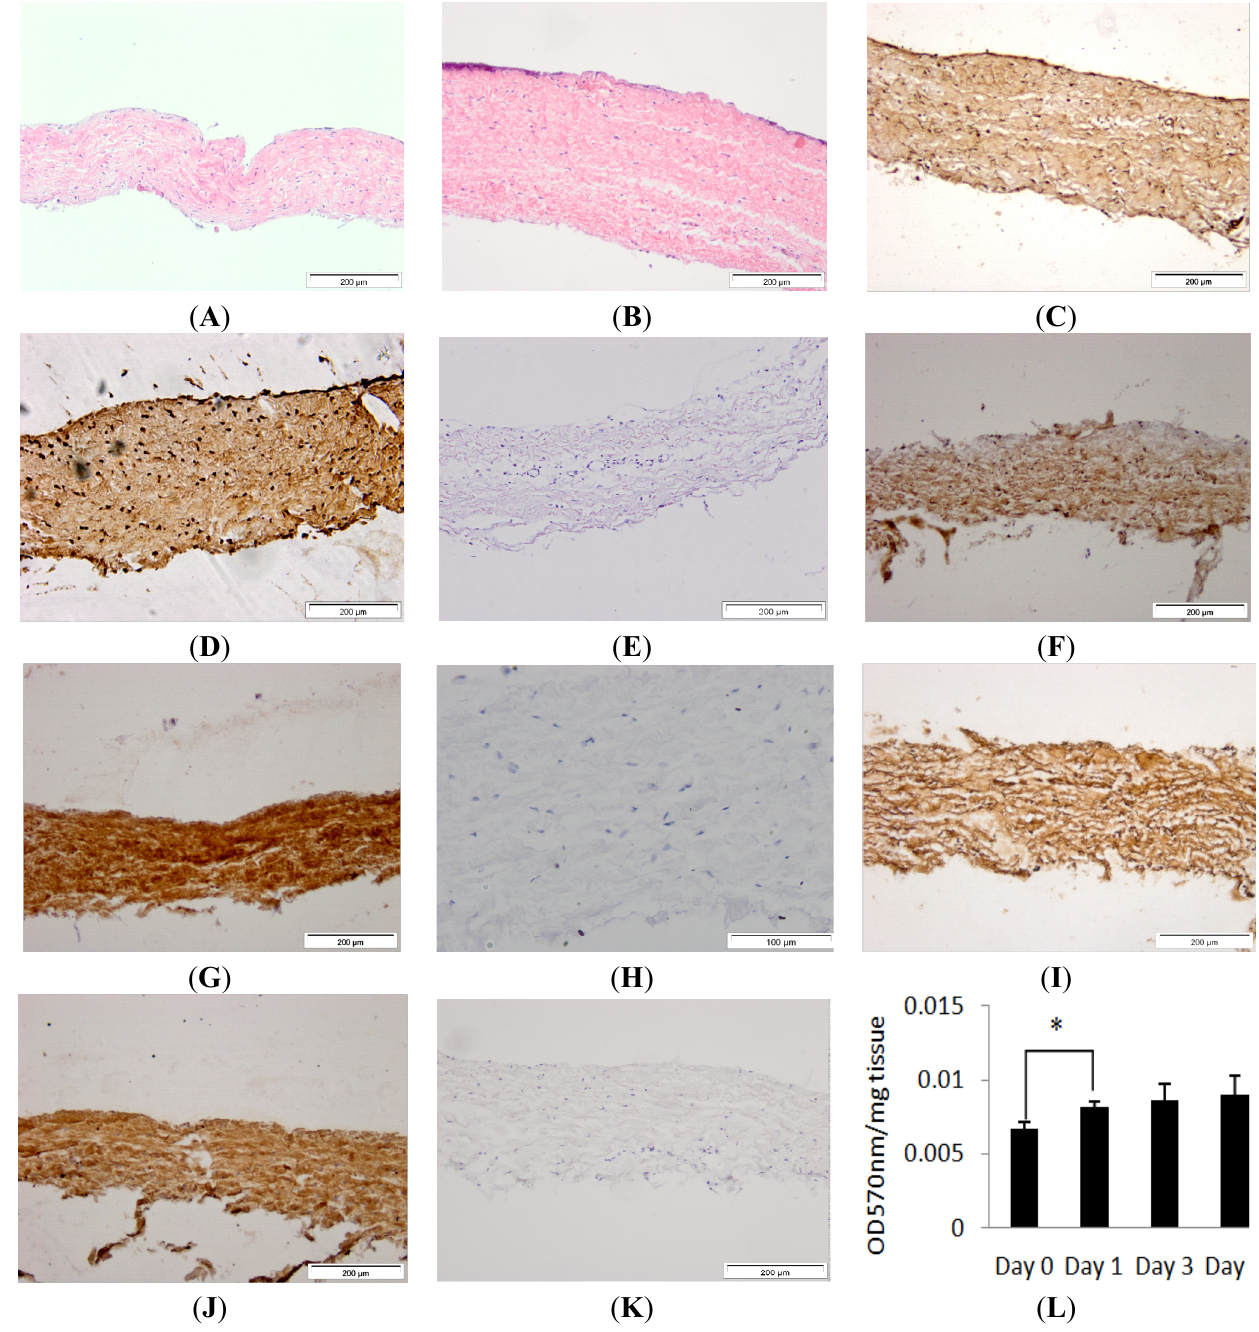
Figure 1. Images of histological sections of the isolated porcine dura-mater tissue at Day 0 ( A ) and after seven days in organ culture ( B ) stained with H&E. Immunohistochemical staining of the porcine dura mater with antibodies to fibronectin ( C , D ), collagen I ( F , G ), collagen II ( I , J ) at Day 0 and Day 7 respectively. Isotypes controls for fibronectin ( E ), collagen I ( H ) and collagen II ( K ) antibodies. Tissue viability over a period of 7 days in organ culture as determined by MTT assay ( L ). Results are presented as OD at 570 nm per mg of wet weight of tissue. Data is presented as the mean ( n = 3) ± 95% confidence limits. Data were analysed by one-way analysis of variance and individual differences between group means determined by the T-method. * indicates significant difference (* p <